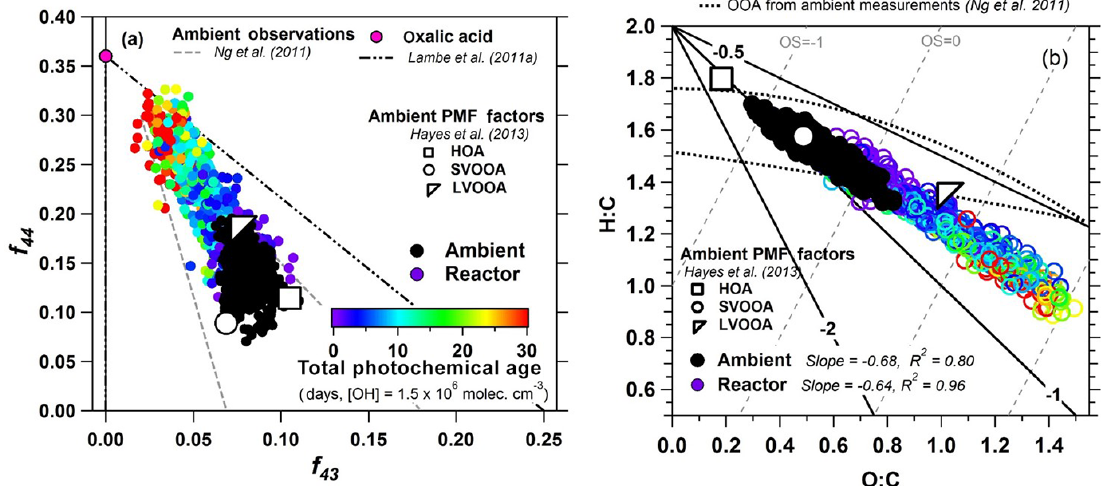
Figure 7. (a) Fractional contribution of m/z 44 ( f 44 ) vs. m/z 43 ( f 43 ) to OA for the ambient and reactor data in this work. The re- gion of ambient observations from Ng et al. (2011b) and the region for reactor laboratory observations and oxalic acid from Lambe et al. (2011a) are shown. (b) Van Krevelen diagram for ambient and reactor measurements for the sampling period. Functionalization slopes from Heald et al. (2010) and oxidation state from Kroll et al. (2011) are shown for reference. Elemental analysis has been calculated with the improved-ambient method from Canagaratna et al. (2015). Reactor measurements are colored by total photochemical age in days (at OH = 1.5 × 10 6 molec.cm − 3 ) and ambient PMF-derived HOA, SVOOA, and LV-OOA factors are shown from Hayes et al. (2013).